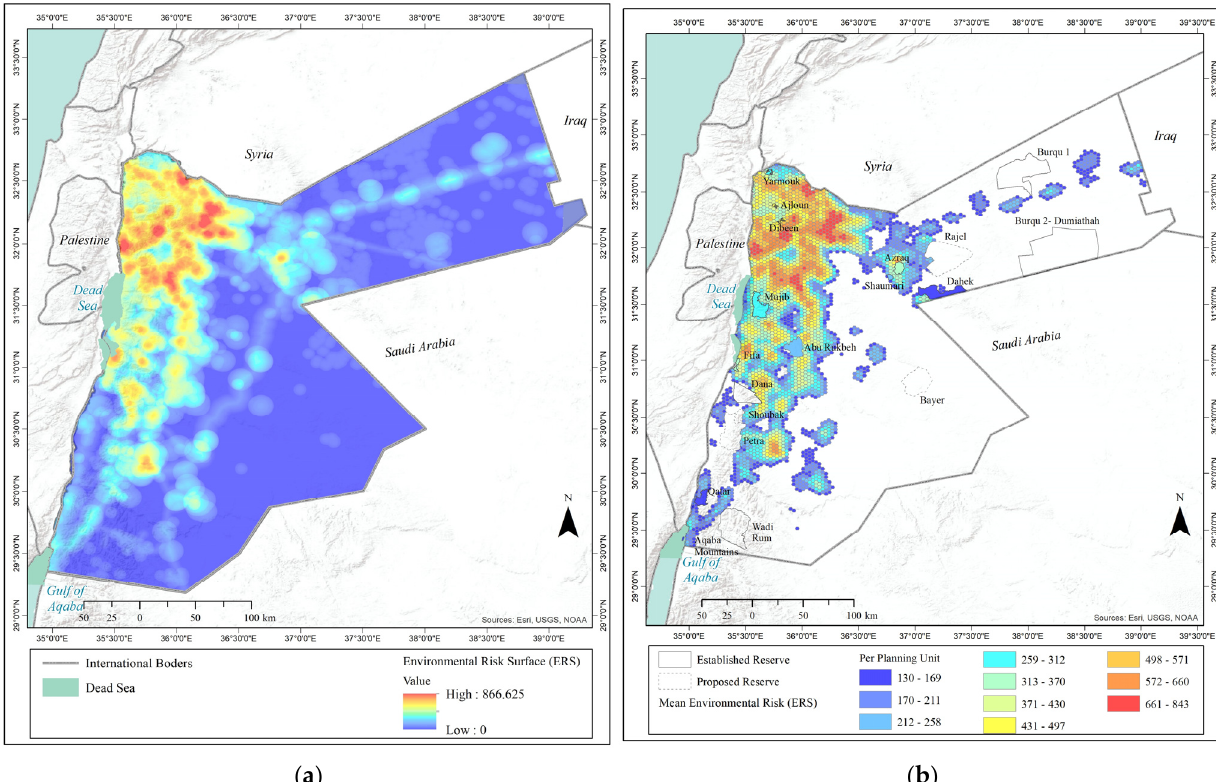
Figure 2. ( a ) The environmental risk surface ERS; ( b ) planning units with above mean environ- mental risk surface ERS